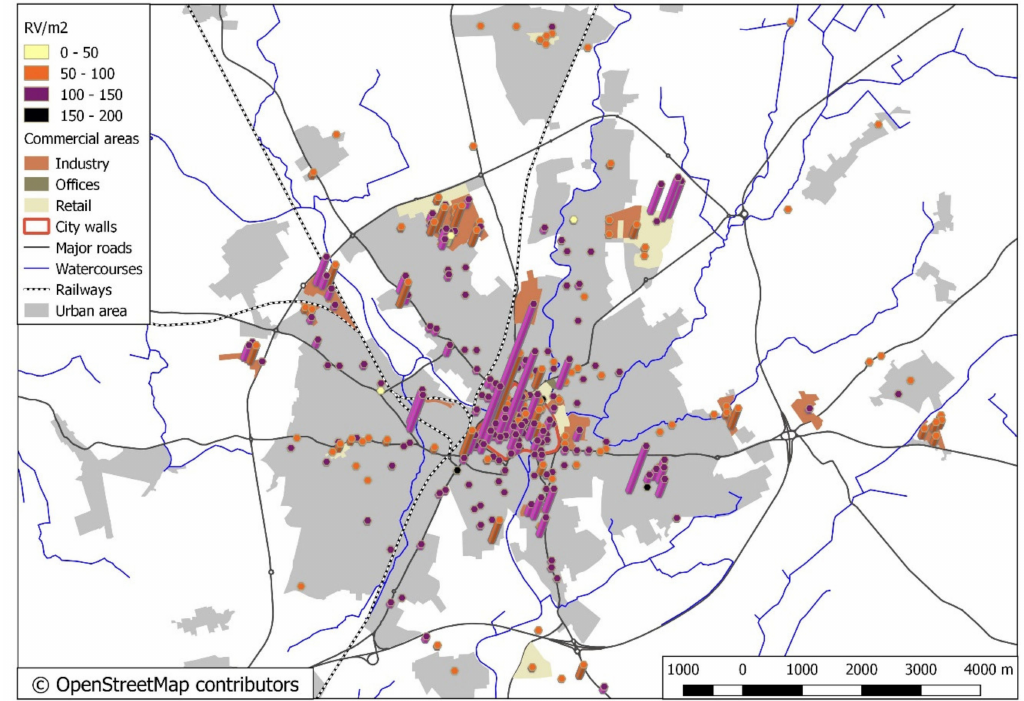
Figure4. O ffi ceRV / m 2 (2019values)aggregatedwithina100mgrid;